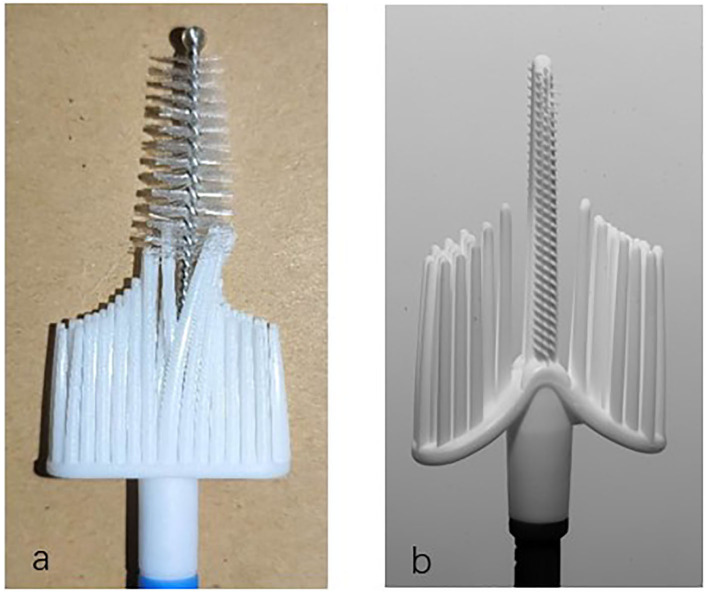
The Qi brush and the Cervex-Brush® Combi. (a) Qi brush. (b) Cervex-Brush® Combi.